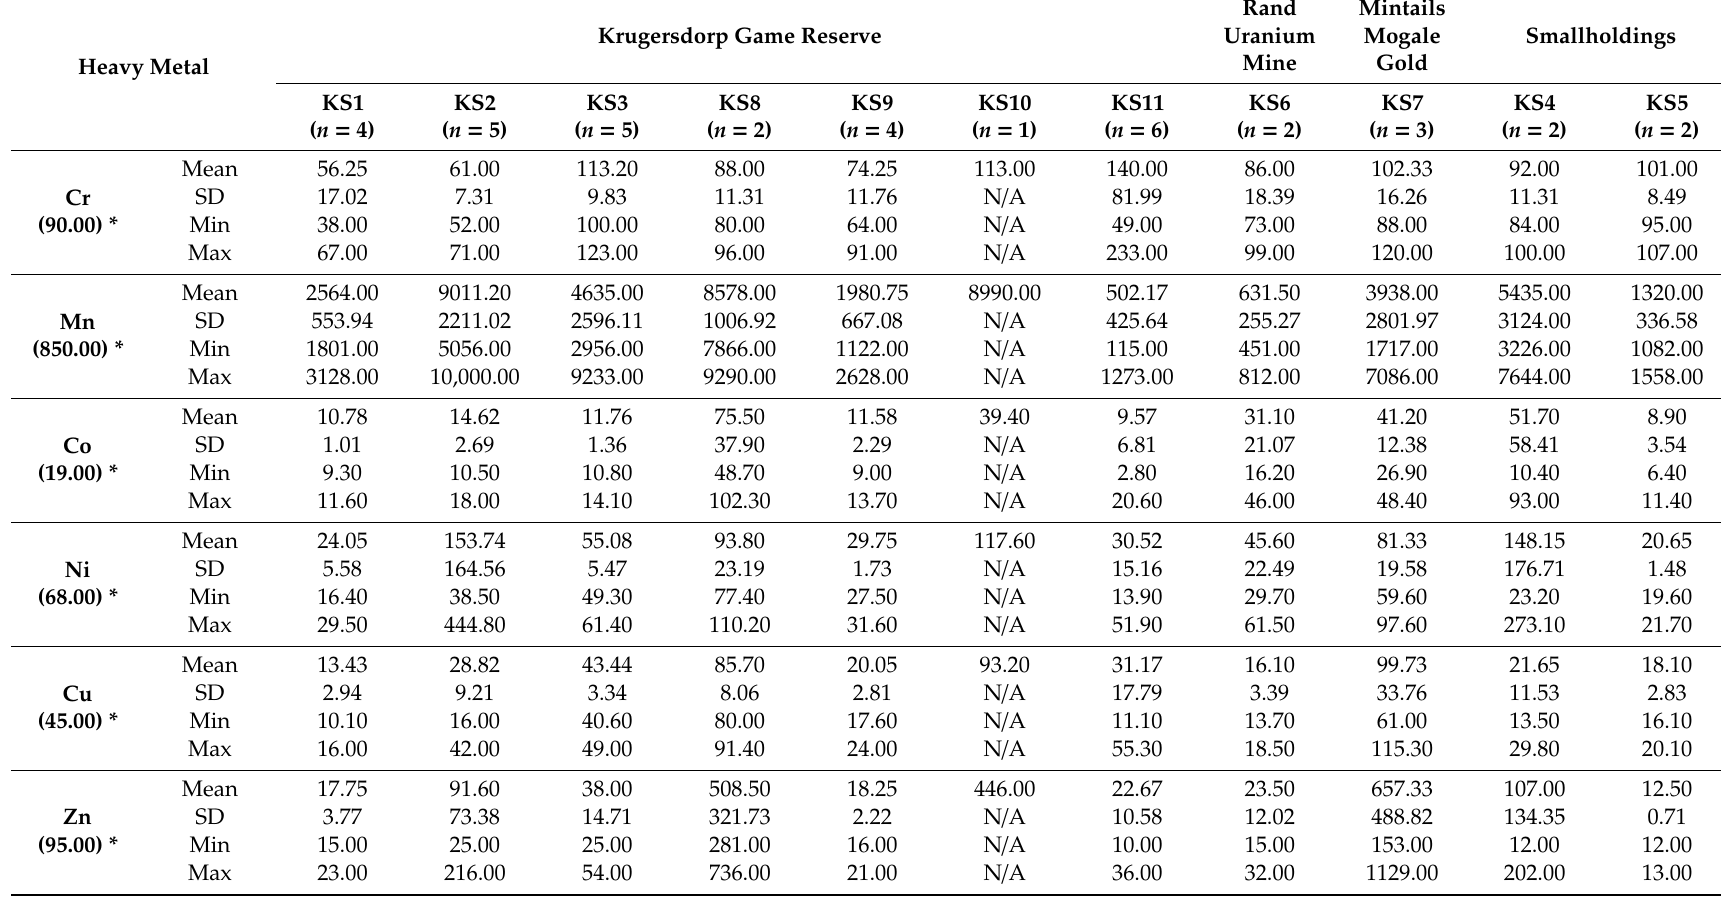
Table 3. Full table of selected heavy metal concentrations (mg · kg − 1 ) in the Krugersdorp Game Reserve, Rand Uranium Mine, Mintails Mogale Gold and surrounding